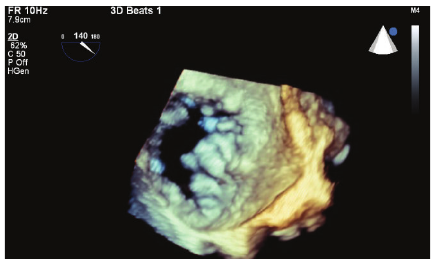
Figure 2: TEE three-dimensional view of aortic valve showing heavy calcification.